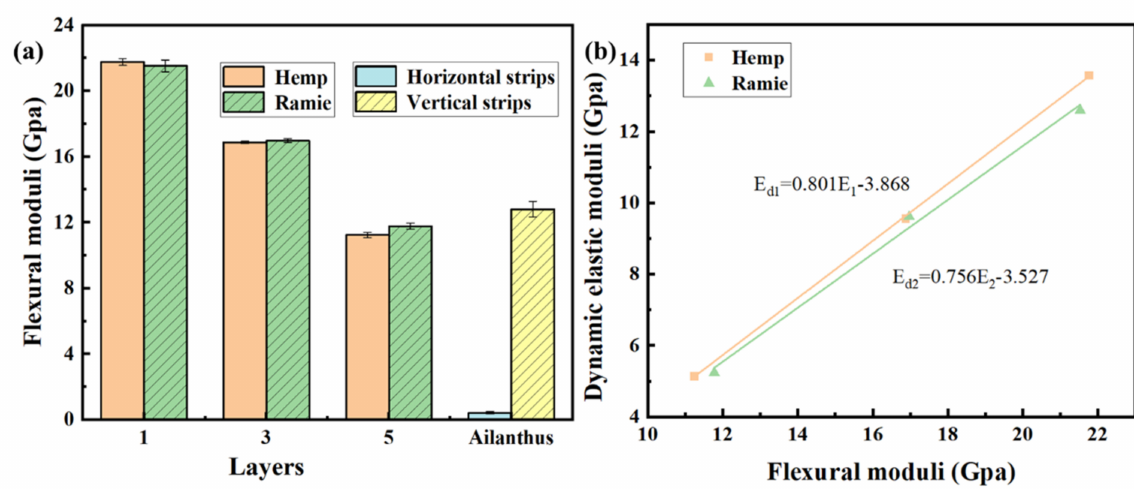
Figure 6. ( a ) The flexural moduli of different layers of composites and ailanthus; ( b ) the relation between dynamic elastic moduli and flexural